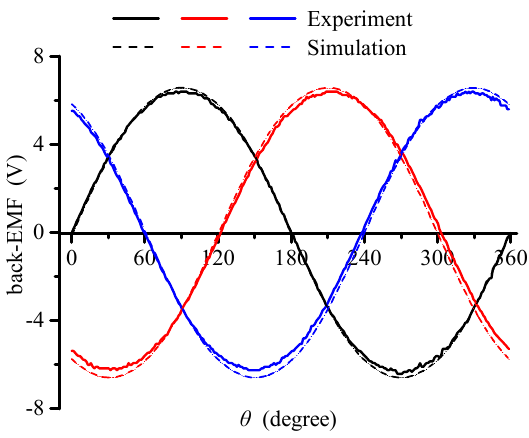
Figure 13. Comparison of the no-load back-EMF waveform between the simulation result and experiment result.